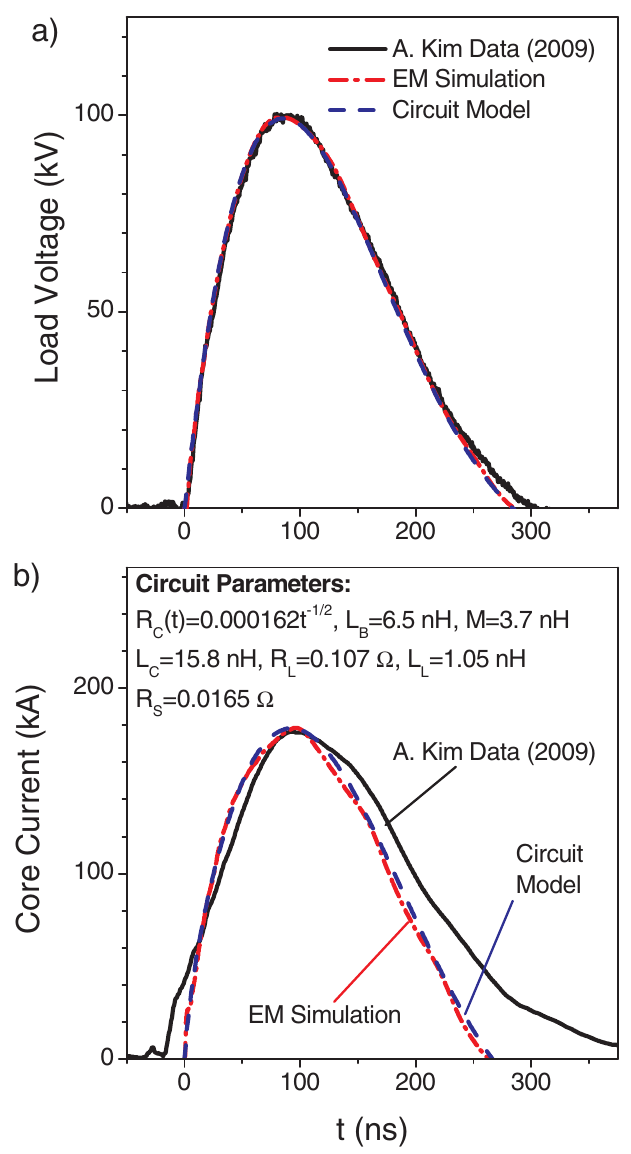
FIG. 4. (Color) Comparison of (a) load voltages and (b) core currents. The black curves are measured traces from Ref. [5] with R L ¼ 0 : 107 (cid:2) . The blue curves are from the circuit model calculations and the red curves are from a 3D LSP single-cavity simulation.